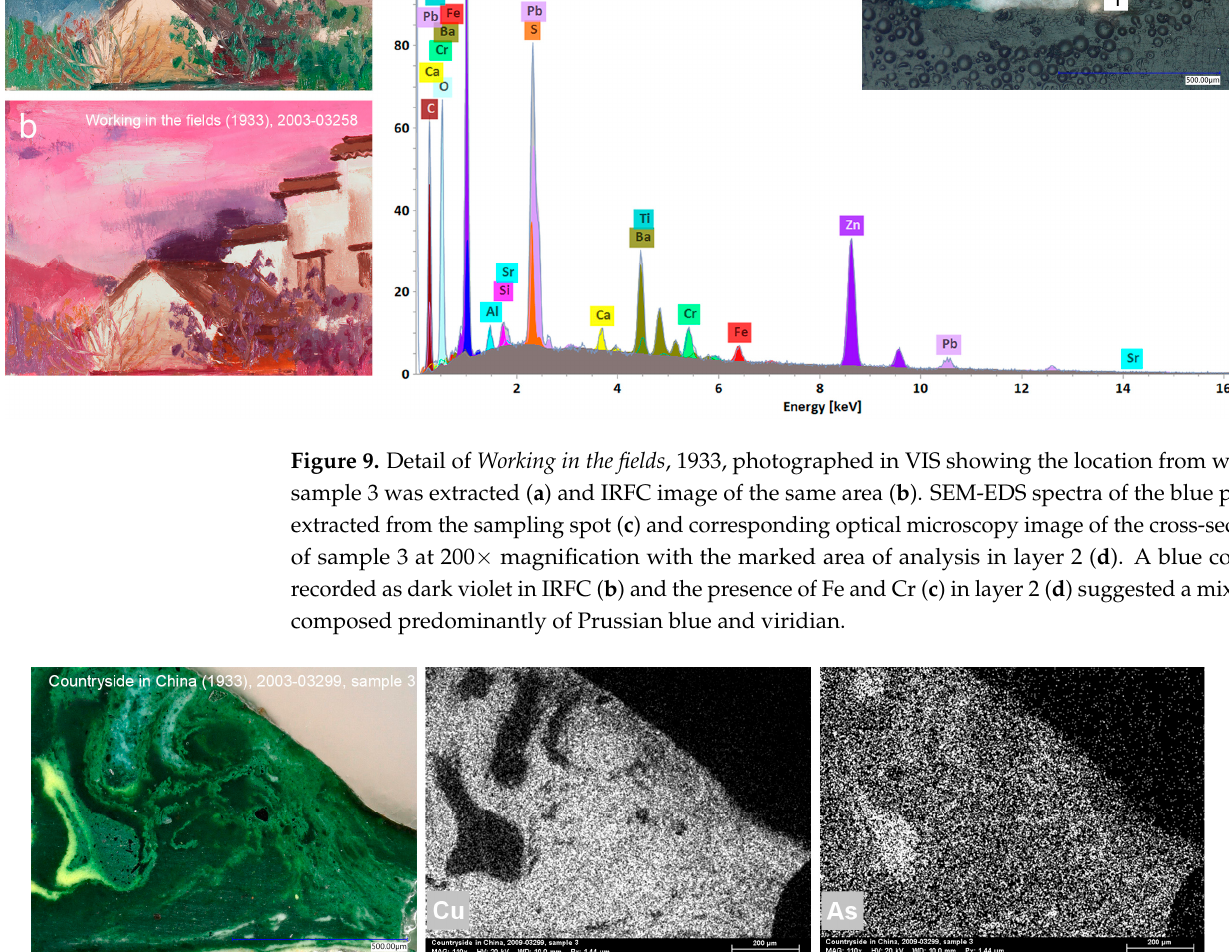
Figure 11. ATR–FTIR spectra obtained from the green paint of sample 10, extracted from Backyard , 1934 with labelled marker peaks of strontium yellow and reference spectra of the same pigment. A combination of Prussian blue and yellow chromate pigment(s) is assumed in some green paint samples. Although Prussian blue was positively identified with FTIR, a precise attribution of yellow chromate pigments was challenging due to their overlapping bands and signal interferences of other compounds. For example, FTIR of the green paint in sample 4 from Seaside (1936) implies the presence of zinc yellow (PY36) (937, 872 and 820 cm − 1 ), chrome yellow (PY34) (839 and 820 cm − 1 ), barium yellow (PY31) or strontium